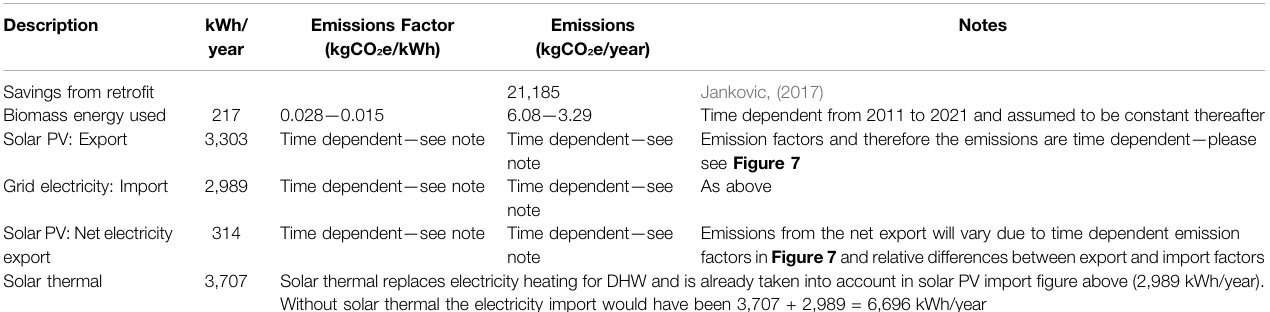
TABLE 11 | Operational